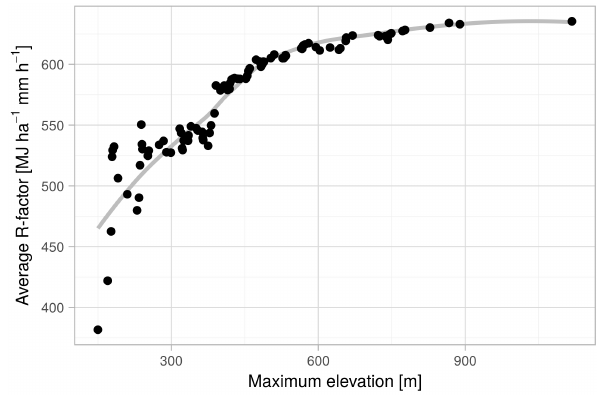
Figure 2. Average R factor for subsets of stations with smaller el- evations than that plotted on the horizontal axis. The leftmost point corresponds to a station with the lowest altitude, the rightmost point to the overall average R